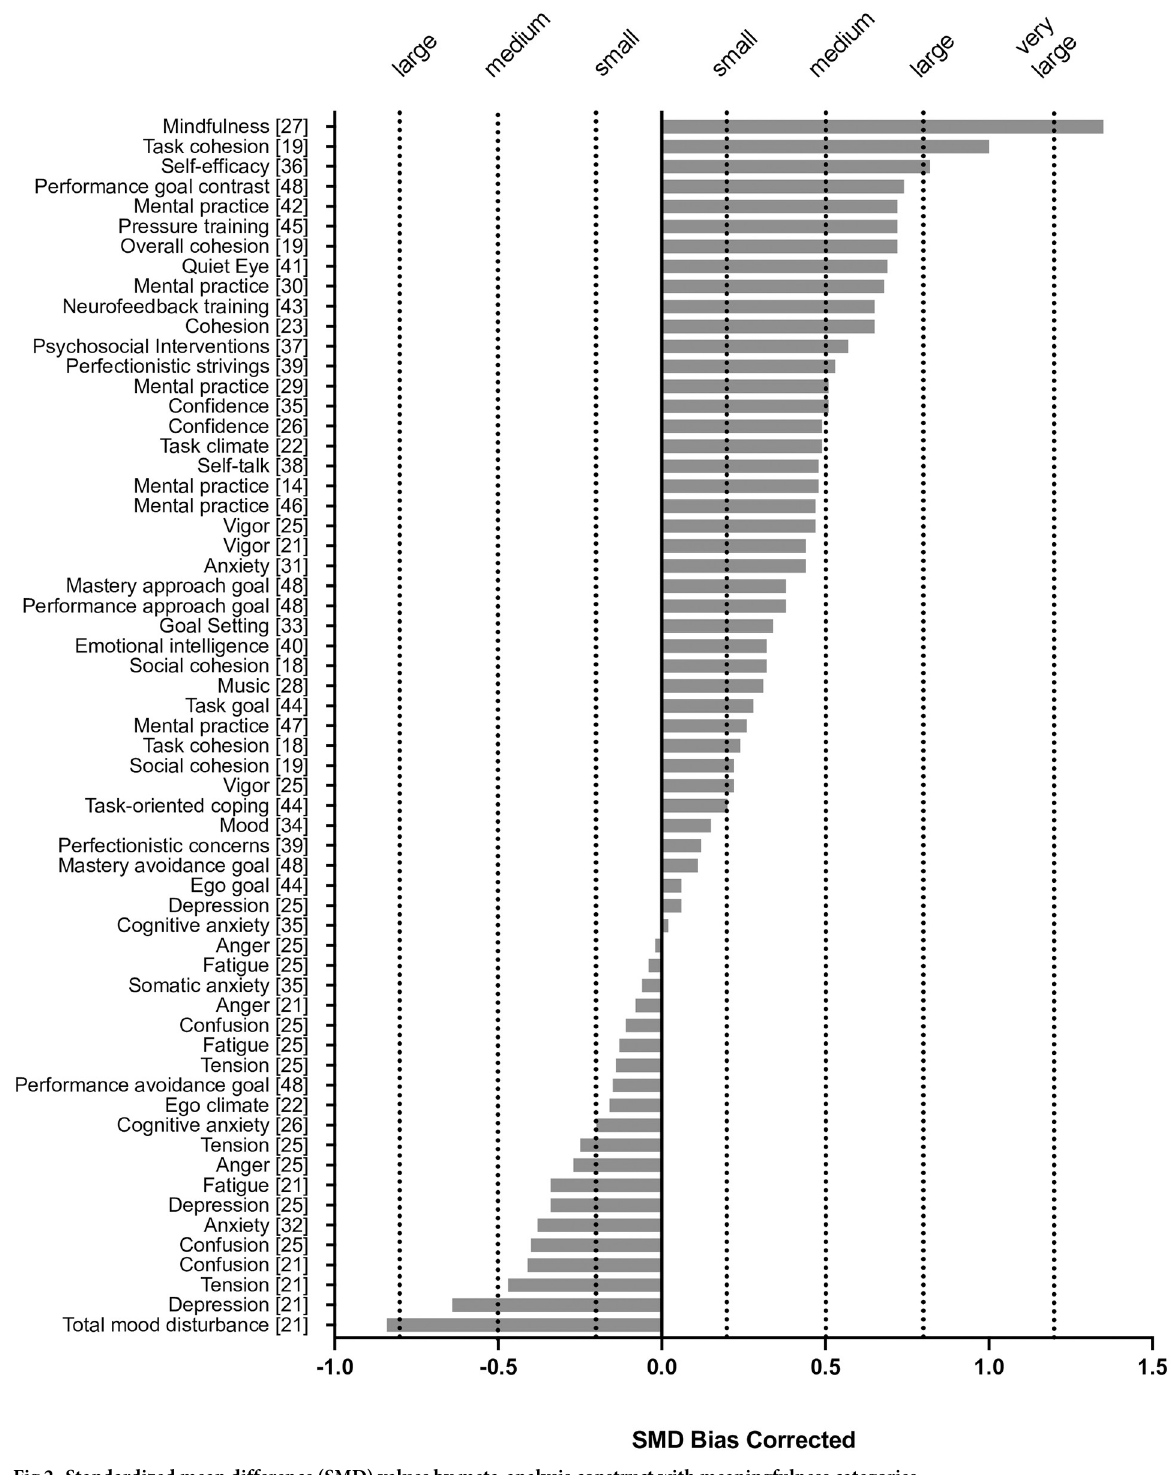
PLOS ONE | https://doi.org/10.1371/journal.pone.0263408 February 16, 2022 14 /